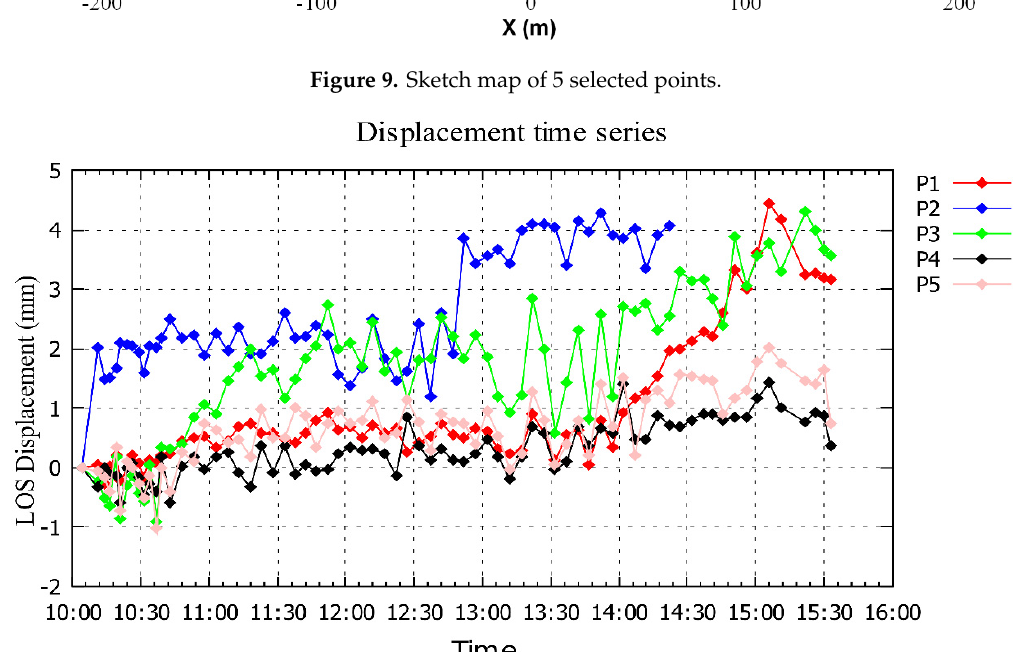
Figure 10. Deformation of each selected point during the monitoring period.